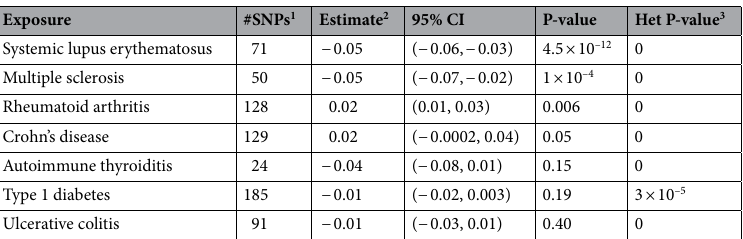
Table 1. Genetic associations between genetic instruments for 7 common autoimmune diseases and white blood cell counts using inverse variance weighted (IVWR) method. CI confidence interval. 1 Number of single nucleotide polymorphisms (SNPs) included in the genetic instrument. 2 Change in transformed white blood cell count per unit increase in the log-odds of the autoimmune disease. 3 Cochran’s